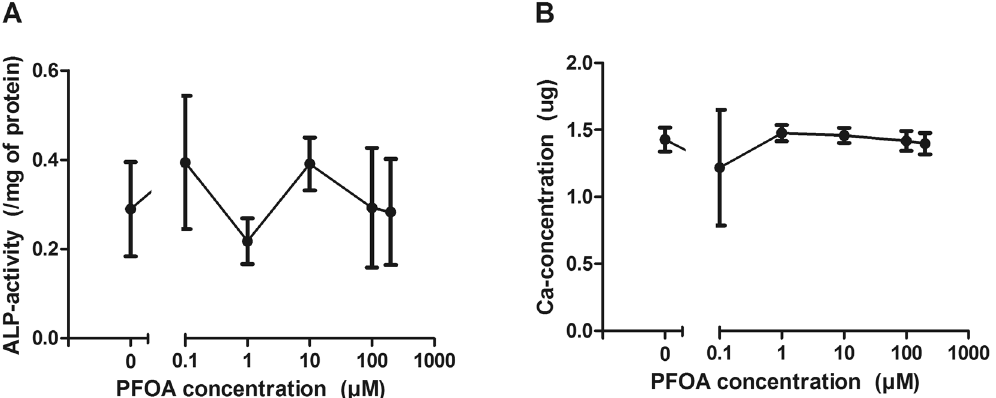
Figure 4. Effect of PFOA on ALP-activity ( A ) and calcium concentrations ( B ) in cultured human osteoblasts after exposure for 3 or 5 weeks. Plots represent mean ±